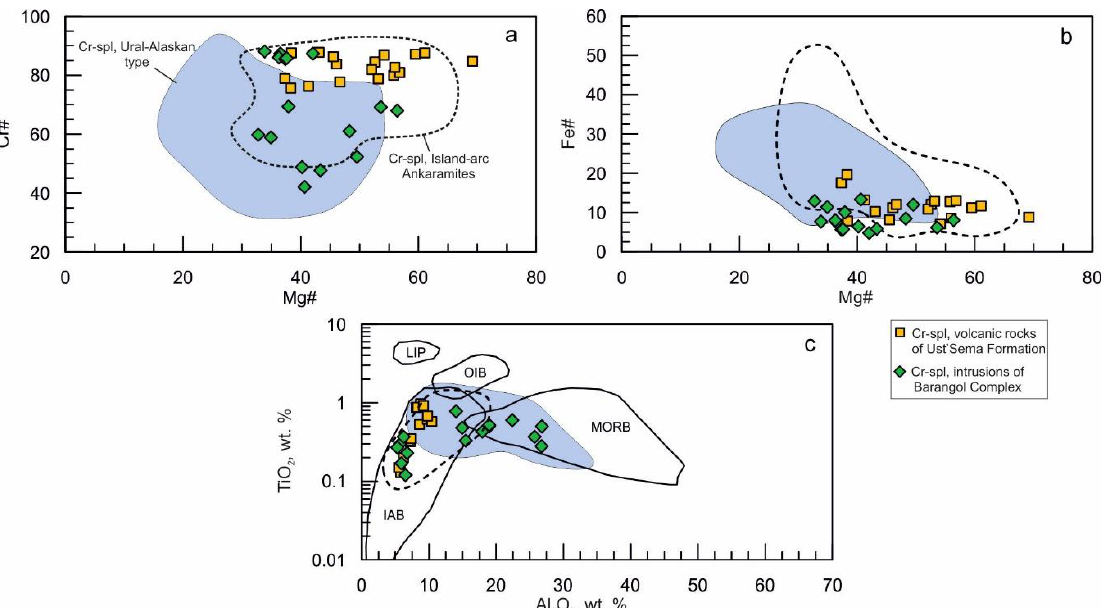
23 of 26 Figure 13. ( a , b ) Chondrite-normalized spectrum distribution of the rare-earth elements [26] and ( c , d ) primitive mantle-normalized spider diagrams [32] for the clinopyroxenes from the Ust’ -Sema Formation and the Barangol Complex rocks compared with clinopyroxene compositions from is- land arc ankaramites [33] and mantle lherzolite of the Kamchatsky Mys [31] are shown. Continued line: core of crystal; dashed line: rim of crystal with clinopyroxene from island arc ankaramites [33], Ural – Alaskan-type intrusions [42], and basalts of the Aleutian arc [48]. Common features also included high Mg# in clinopyroxene; negative correlations of